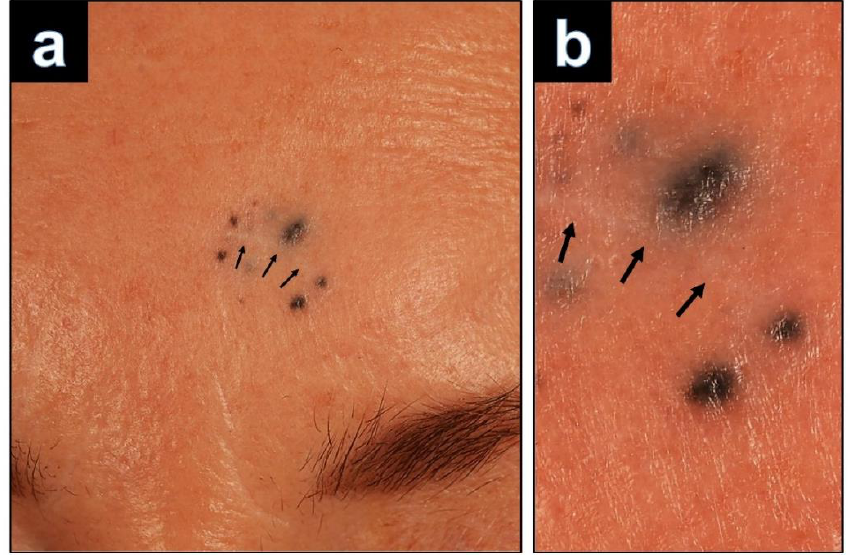
Figure 1. ( a ): Left forehead: at the left side of the forehead, a linear scar (black arrows) with size of 10 × 2 mm is surrounded by eight blue-black satellite lesions measuring up to 2 mm. ( b ): Magnifi- cation of the satellite